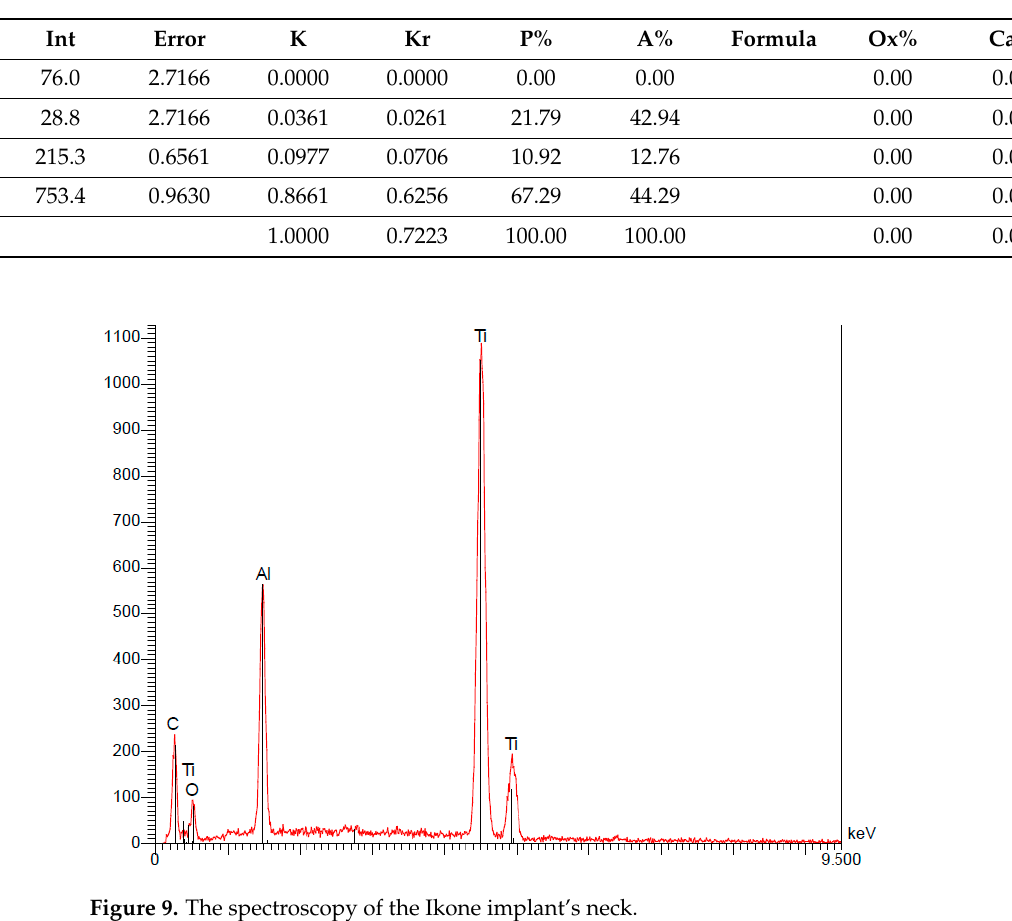
Table 7. The quantitative results of the EDS analysis of the Inkone implant’s neck demonstrating the weight percentages (P%) and atomic percentages (A%) of the elements detected.